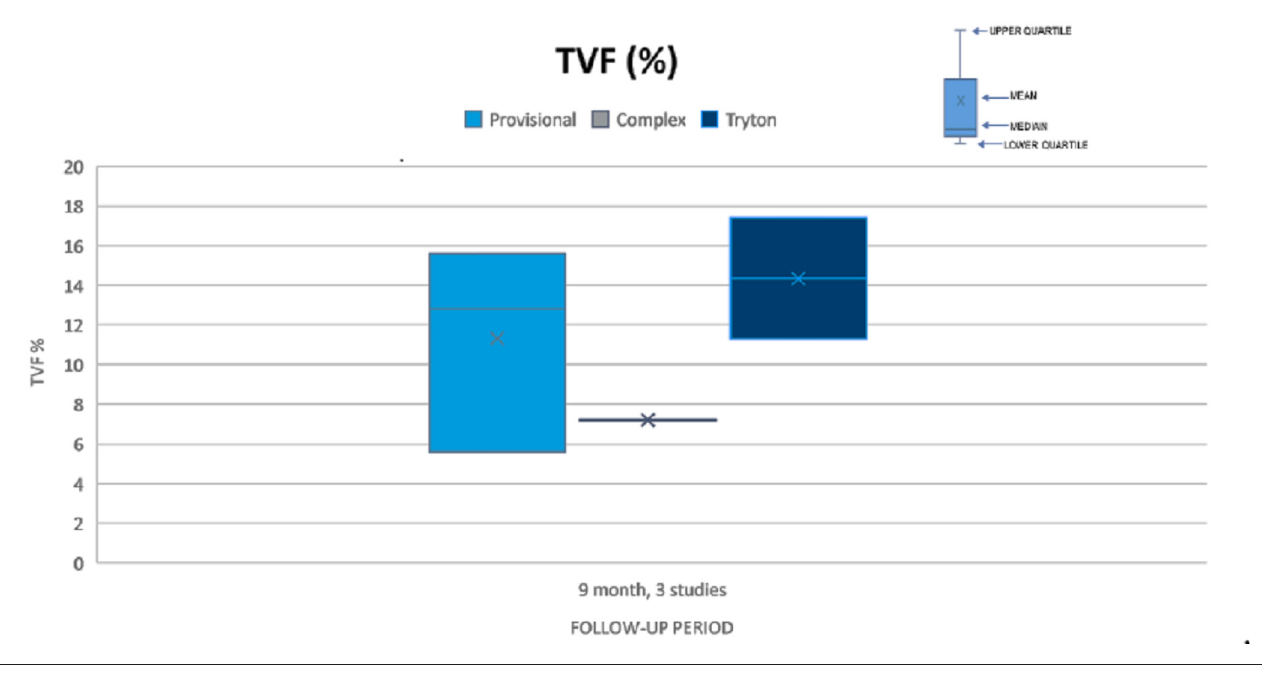
Figure 2. Studies reporting TVF (%) at 9 months. TVF: target vessel failure